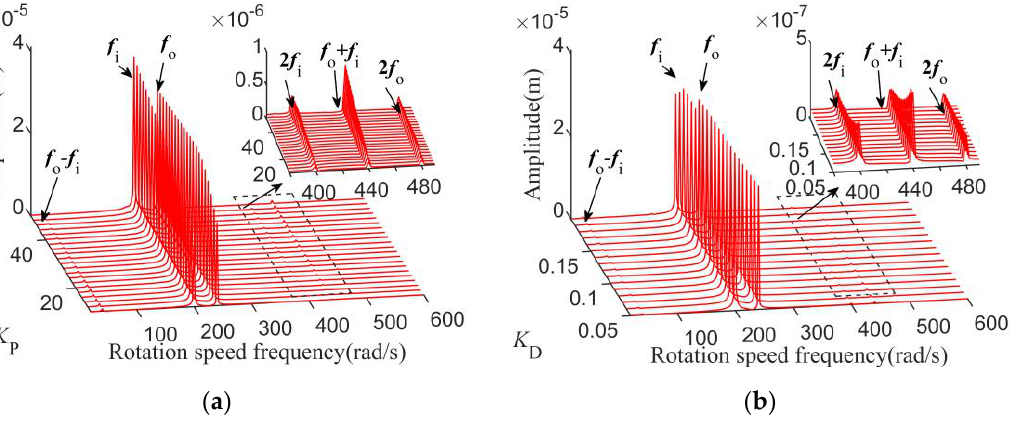
Figure 16. Waterfall plots of frequency responses of disk1 under different control parameters. ( a ) KP; ( b ) KD. ( b )